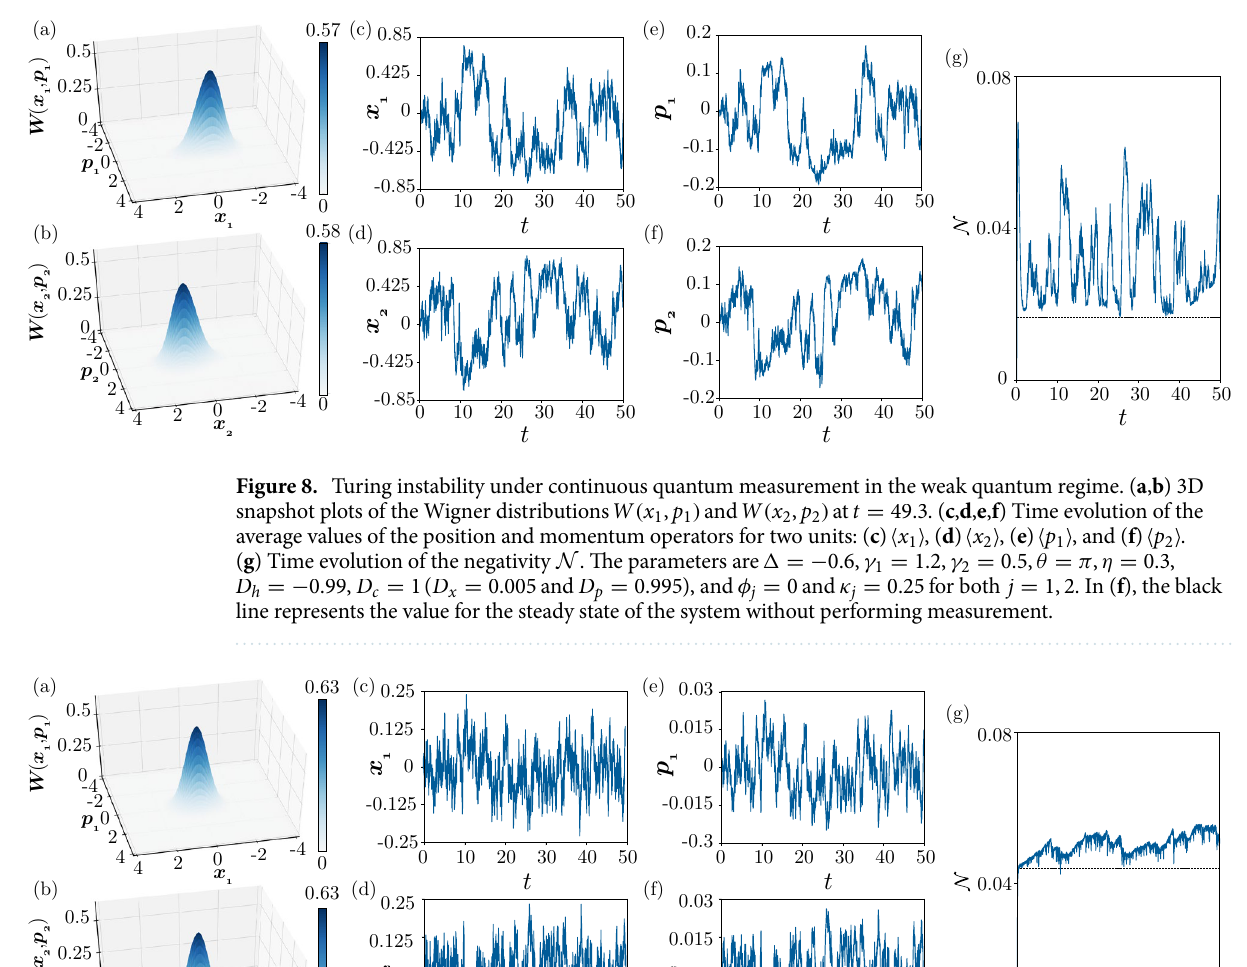
0 10 20 30 40 50